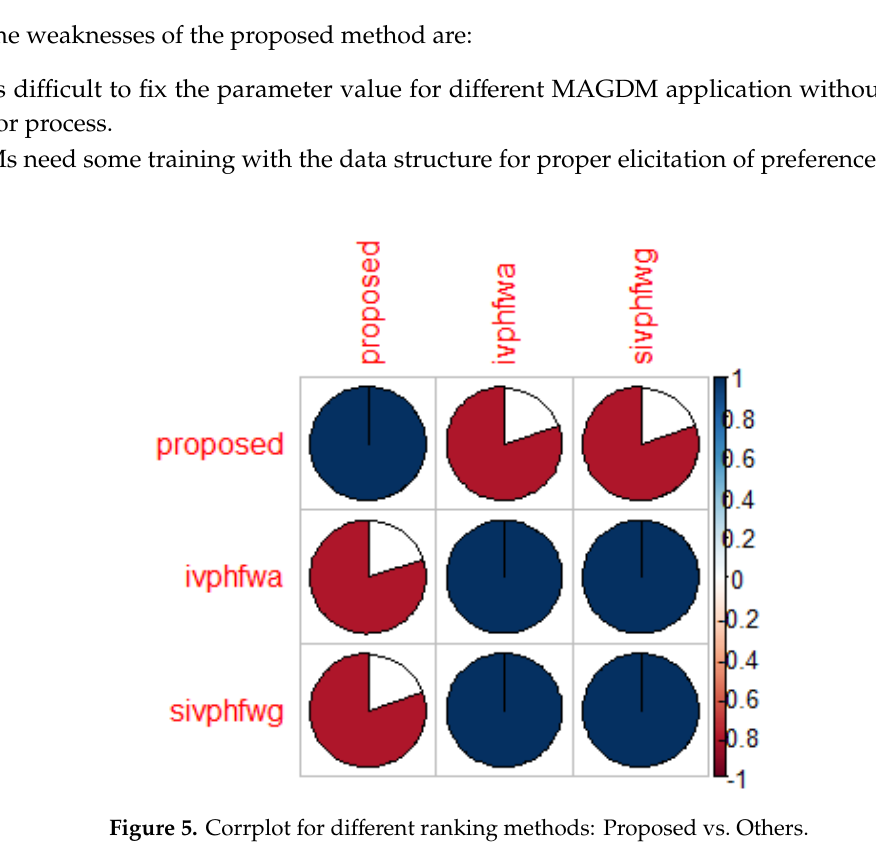
Table 6. The ranking order of renewable energy sources: Proposed vs. Others.